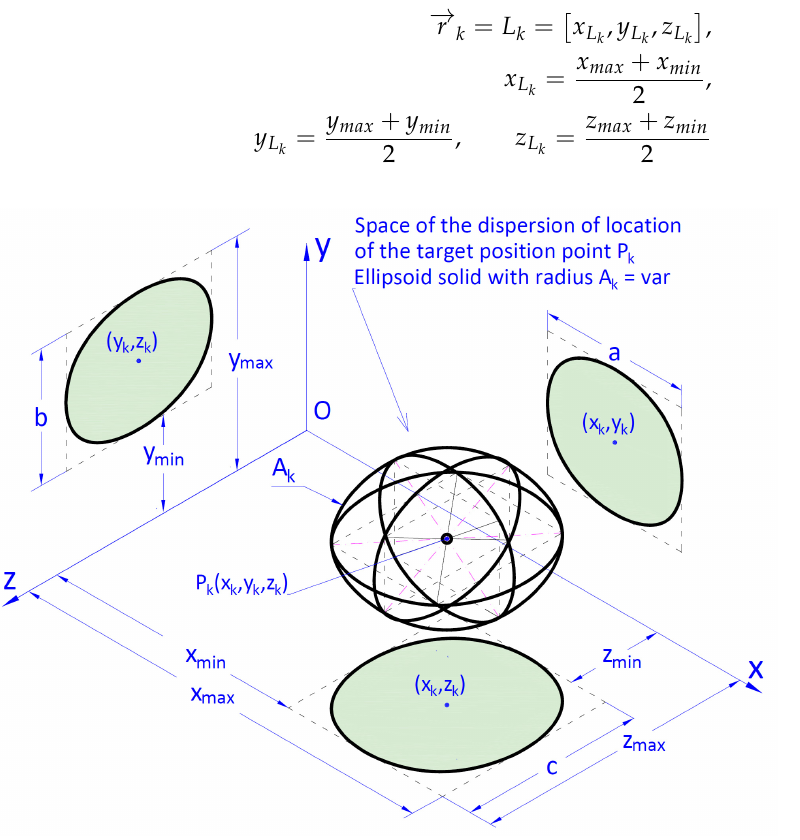
Figure 4. Geometrical interpretation of the positioning accuracy indicator A k . Positioning accuracy of the handling crane when transporting the cargo from the start point P p to the given final point P k